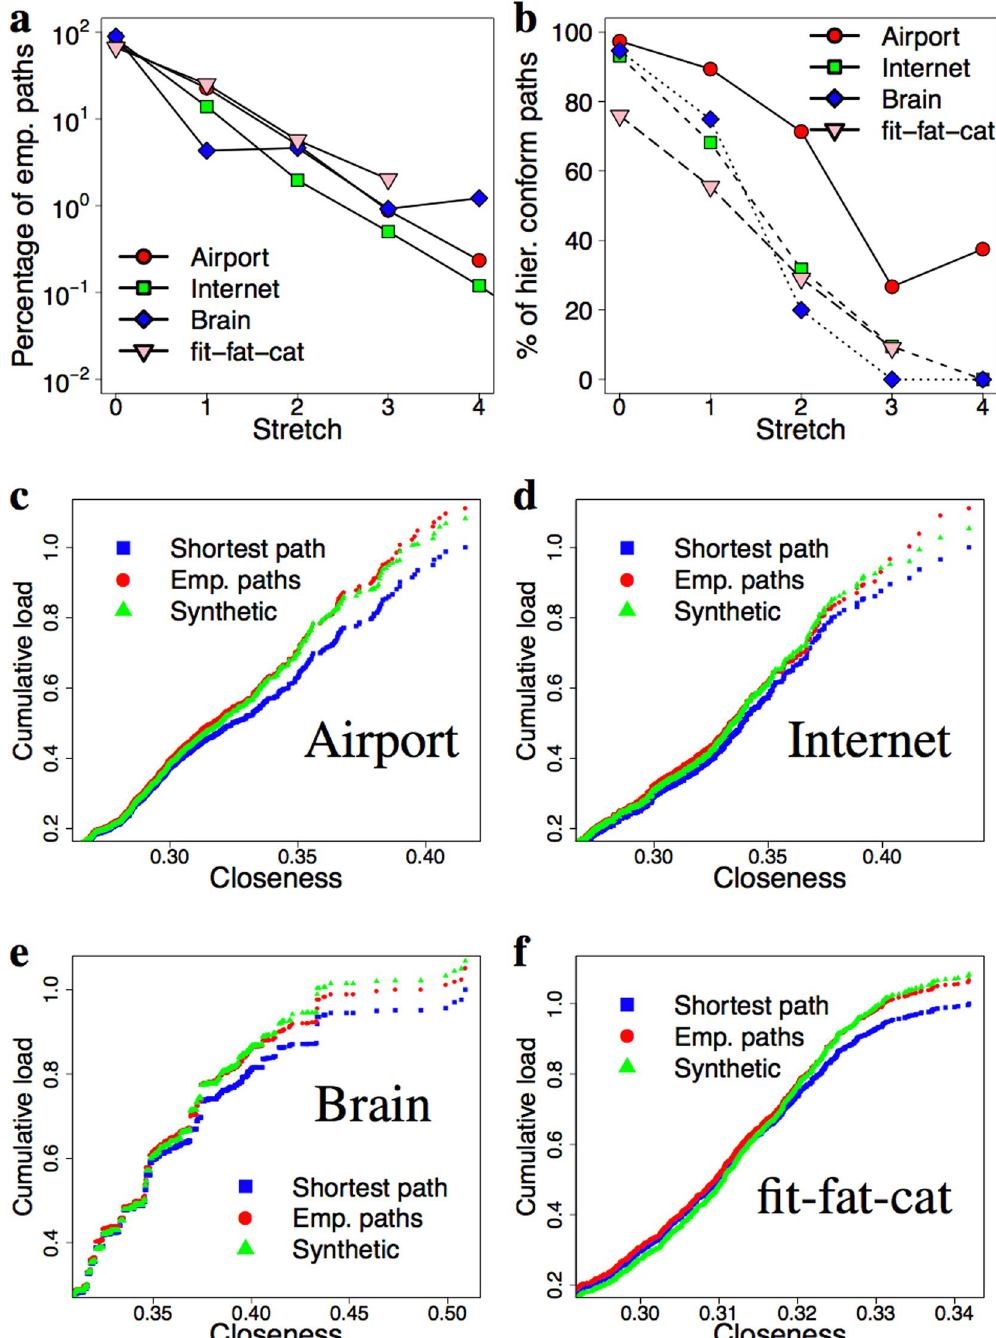
Figure 4. Results of the synthetic routing policy. Our toy policy exhibit very realistic stretch (panel (a)) and CH distribution (panel (b)) (see Figs 2 and 3a–d for comparison). Panels (c–f) present the cumulative load experienced on the nodes as the function of closeness, for our four datasets. The blue squares and the red circles show the load footprint of the shortest path policy and the empirical paths respectively. Due to the stretch of the empirical paths, the empirical plots give larger load that is more concentrated on the core. Our synthetic algorithm (green triangles) approximates this behaviour better than pure shortest